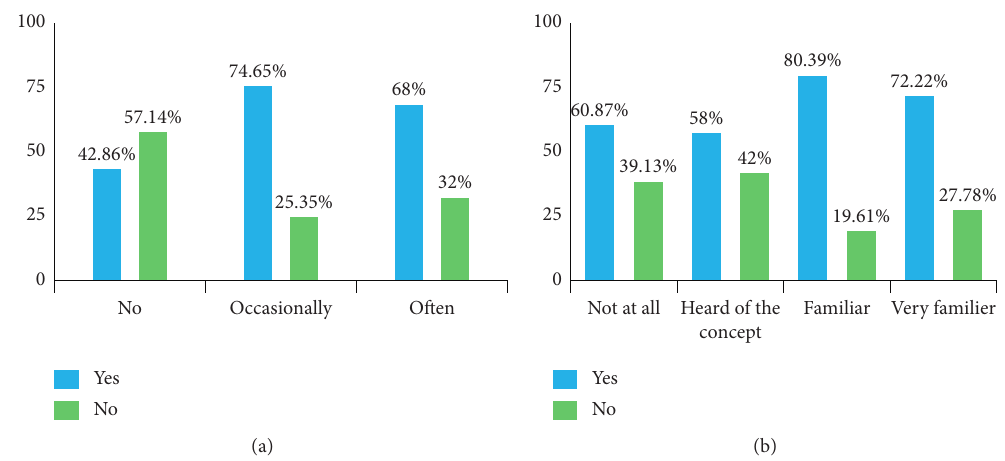
Figure 5: Breakdown of choice behavior according to taxi app usage and familiarity with car sharing.